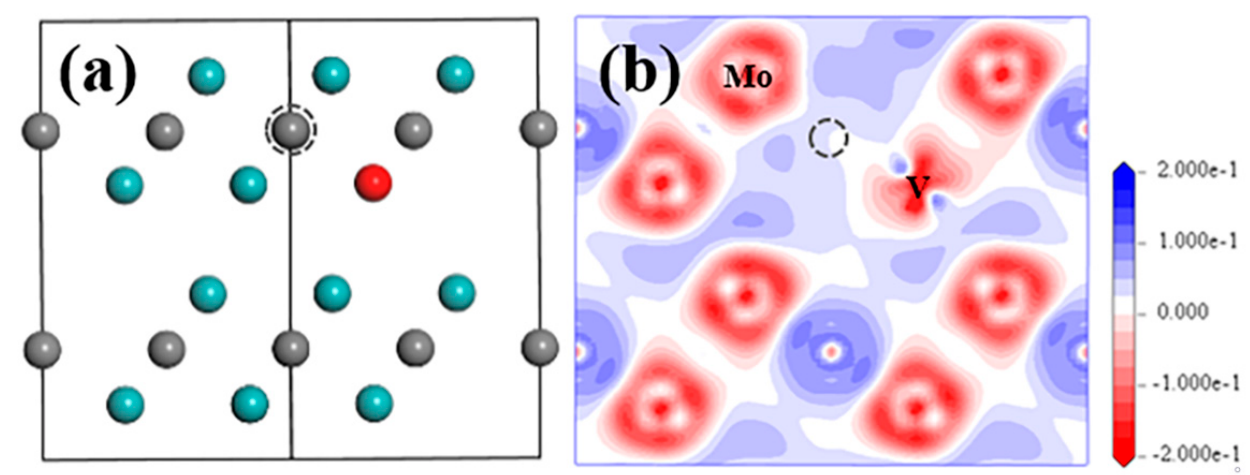
Figure 6. Structure model ( a ) and EDDD ( b ) after optimization in (1120) plane of Mo 2 C supercell with S V-Mo +V C defect. Cyan and grey balls represent Mo and C atom, red ball represents V atom; grey dashed circle shows the V C position.